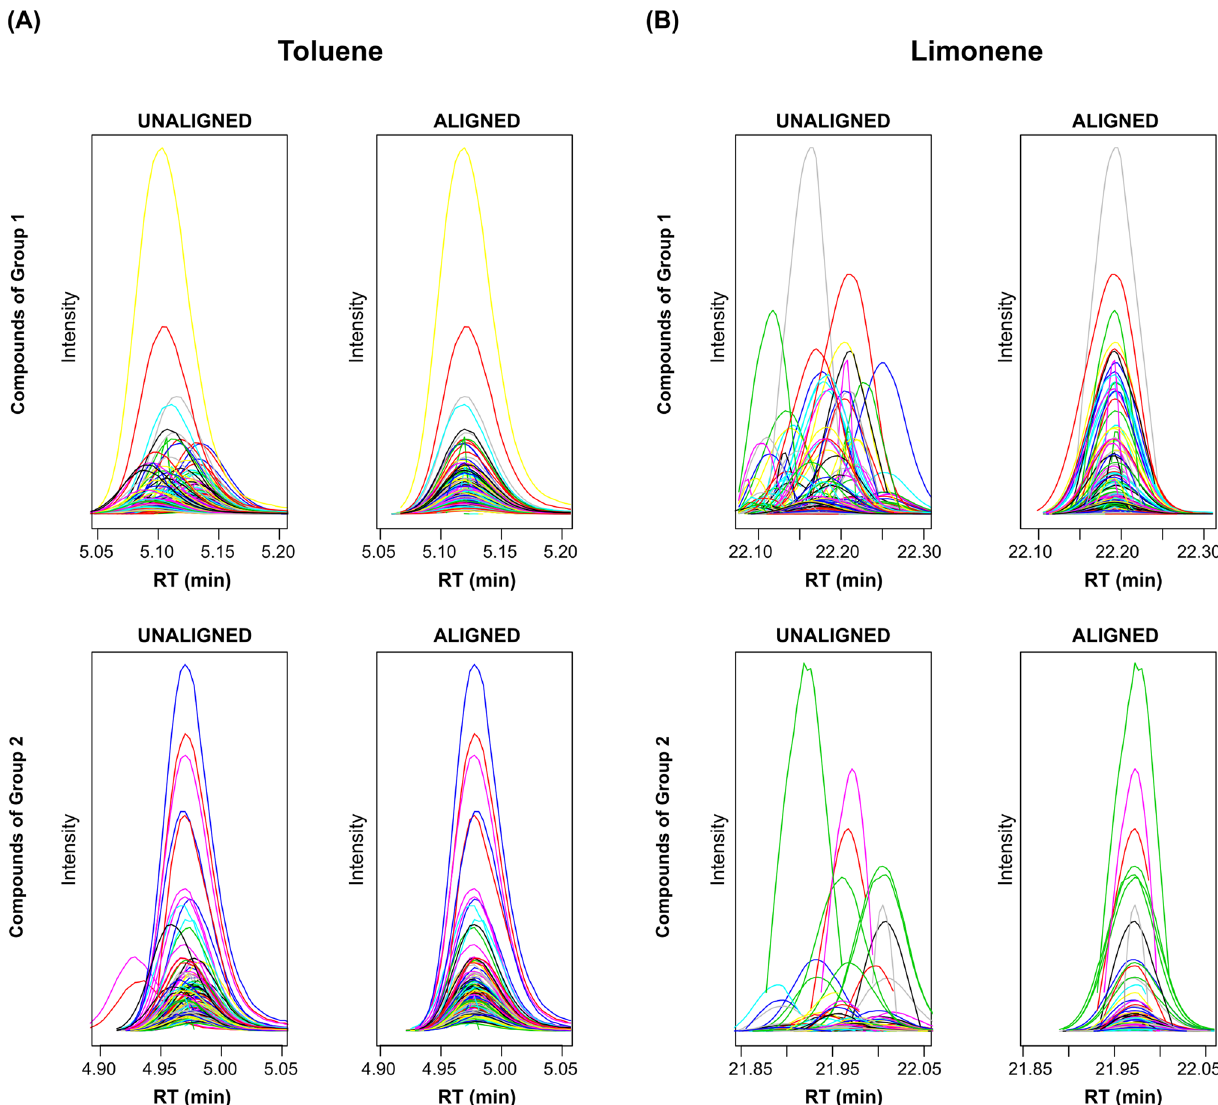
Figure 4. Spectral alignment using eRah . ( A ) Elution profile of toluene in room air content samples from both groups of samples (Group 1 and Group 2) before and after alignment. ( B ) Elution profile of limonene in room air content samples from both groups of samples (Group 1 and Group 2) before and after alignment. Plots of this figure were generated by the plotAlign function of package eRah in ing features was calculated as follows: (average intensity of the feature/average intensity of the feature with the highest intensity) * 1000. Afterwards, each compound obtained using xcms-cliqueMS was compared with all the compounds obtained by eRah . For this purpose, two vectors (one vector for a compound obtained by the first approach and another for a compound of the second approach) were constructed with 412 positions, where each position corresponded to an m/z signal within the range of m/z 38–450. These vectors were filled with the relative intensities (ranging from 0–1000) of ion fragments of each compound. A value of 0 indicated that the m/z signal was not detected in the compound. The dot product between both vectors was calculated, and a single value between 0–1 was obtained. A value close to 1 indicated a high level of similarity between the compounds. Therefore, it was possible to determine which eRah compound was the most similar to the xcms-cliqueMS compound (compound with the highest dot product value). This process is similar to comparing the spectrum of a compound with those of a library 38 . As a result, the compounds determined by both approaches were matched by a dot product. Then, only the eRah compounds detected whose dot product result was the highest for some cliqueMS compounds with a value higher than 0.7 were selected (filtered compounds). Moreover, a second filter was applied. Only the features obtained by xcms that had been previously matched with the filtered compounds of the second approach were selected (filtered features). Table 2 shows the total number of filtered features and filtered compounds of both groups. Furthermore, the feature intensity values were normalized across all the samples from each subset.